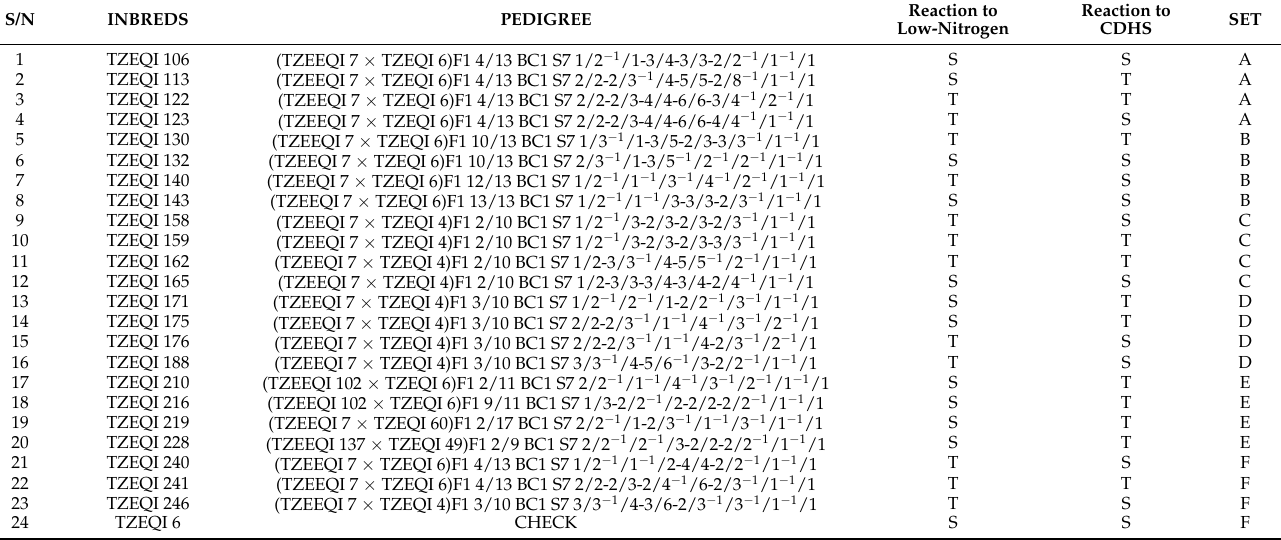
Table 6. List of the 24 early QPM inbred lines used in the North Carolina design II mating design to generate the 96 single-cross hybrids.